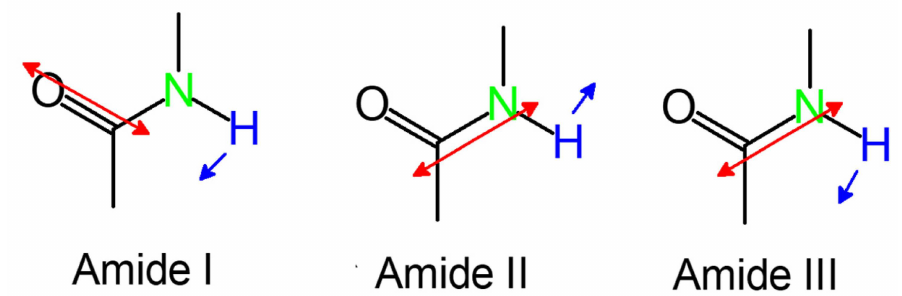
Figure 4. Vibrational modes of amide I, amide II, and amide III. Red arrows, C=O and N–H stretching; Blue arrows, N-H vending.